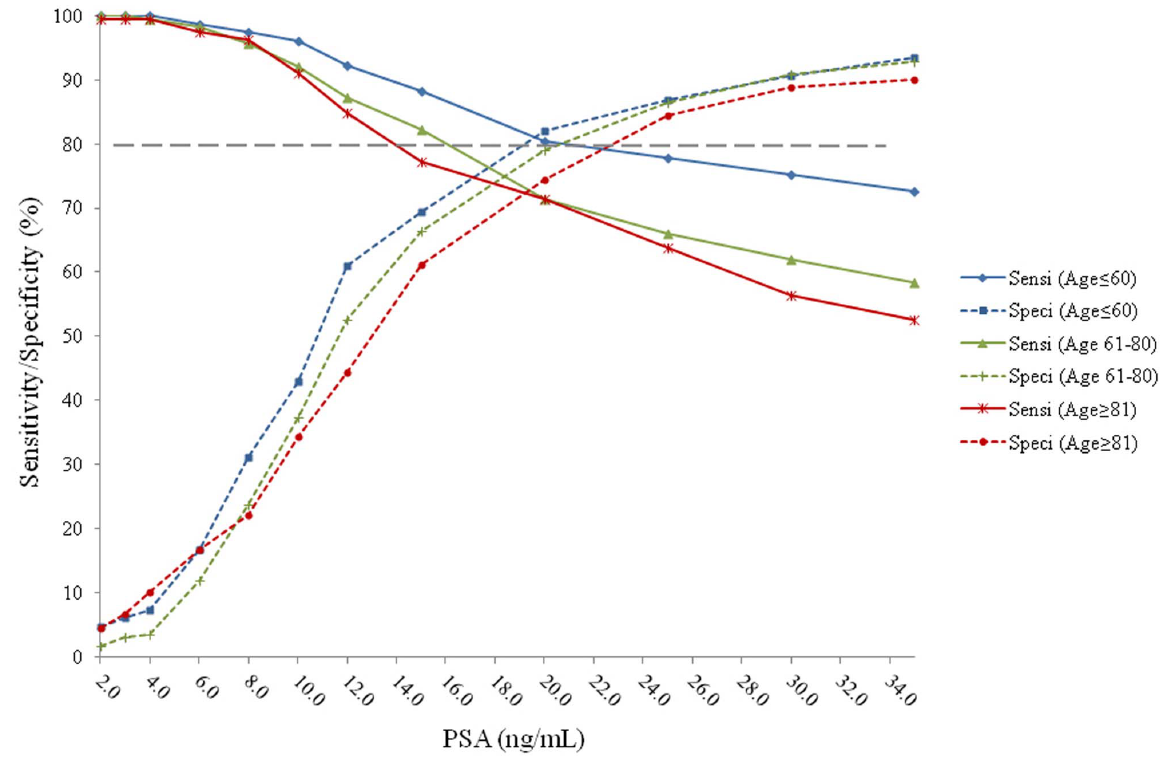
Figure 1. Sensitivities and specificities of PSA predicting PCa plus non-PCa in different age groups. When the specificities were 80%, the sensitivities were 83% with PSA value of 19.0 ng/mL in the age # 60 group; 71% with PSA value of 21.0 ng/mL in the age 61–80 group; and 68% with PSA value of 23.0 ng/mL in the age $ 81 group.